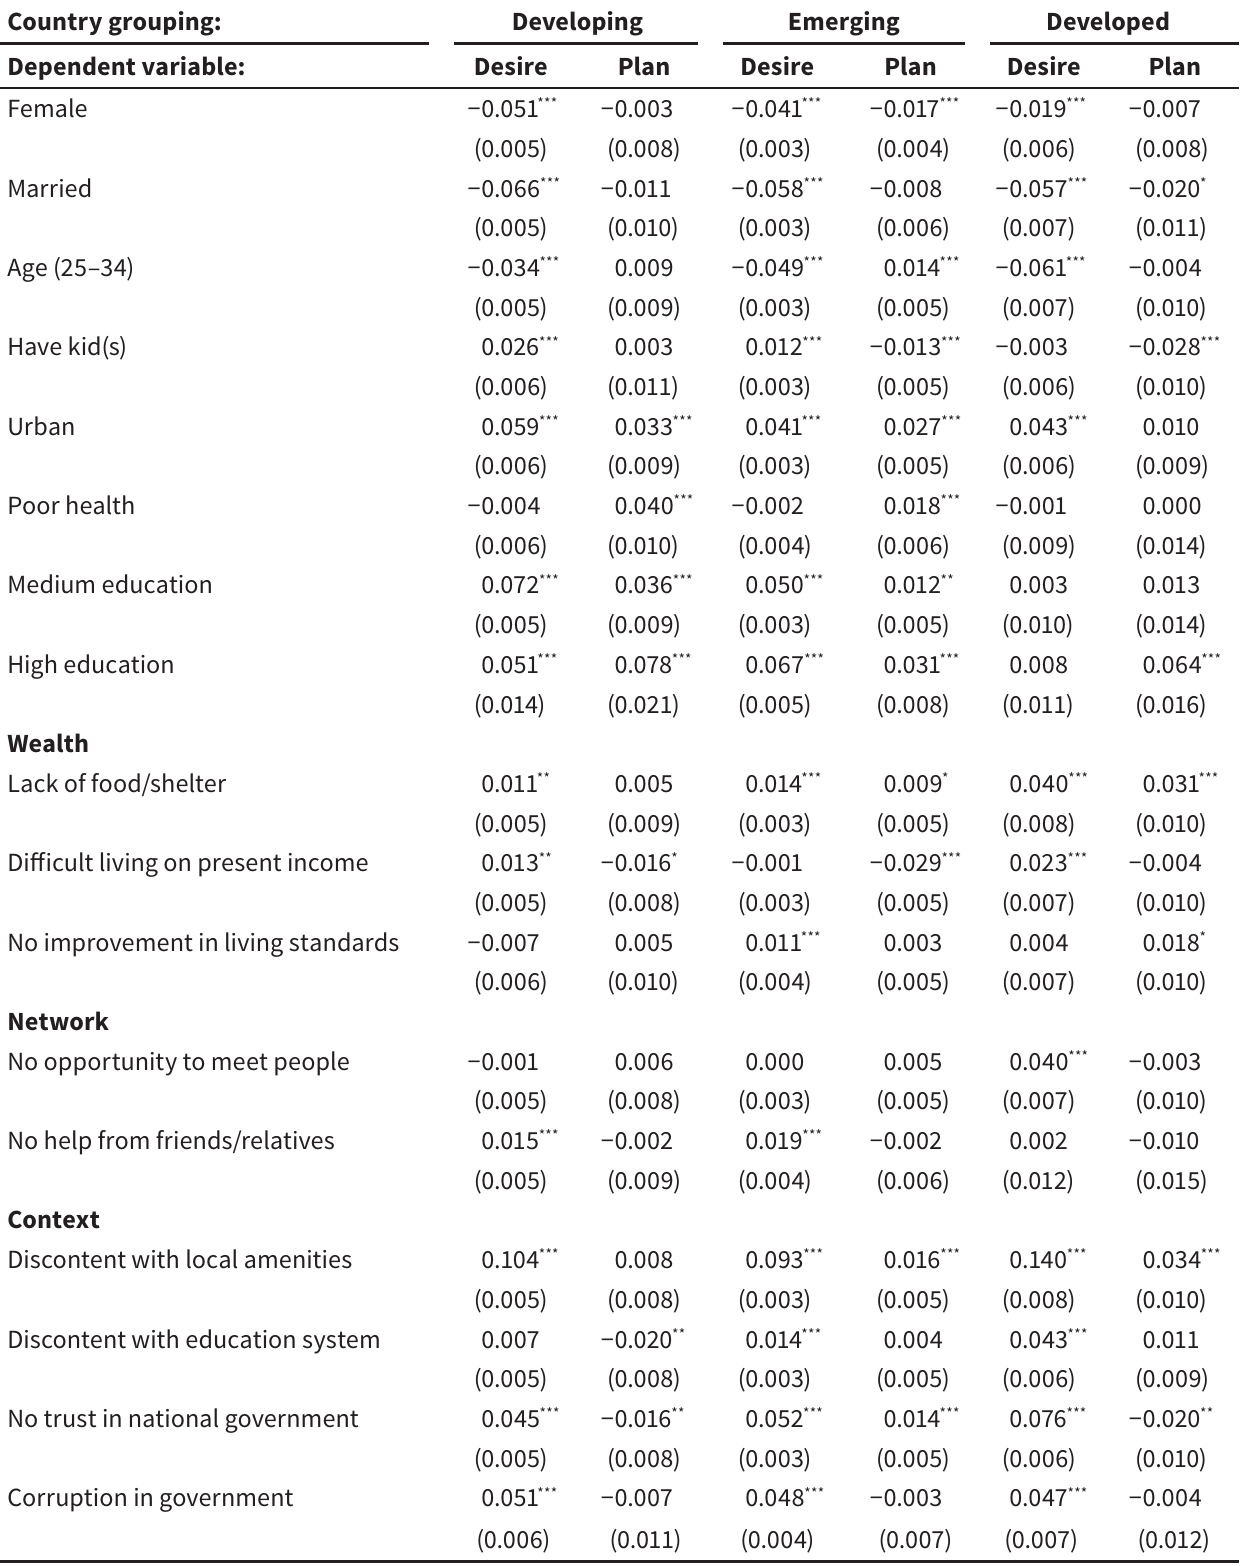
Youth (15–34) desire/plan to migrate